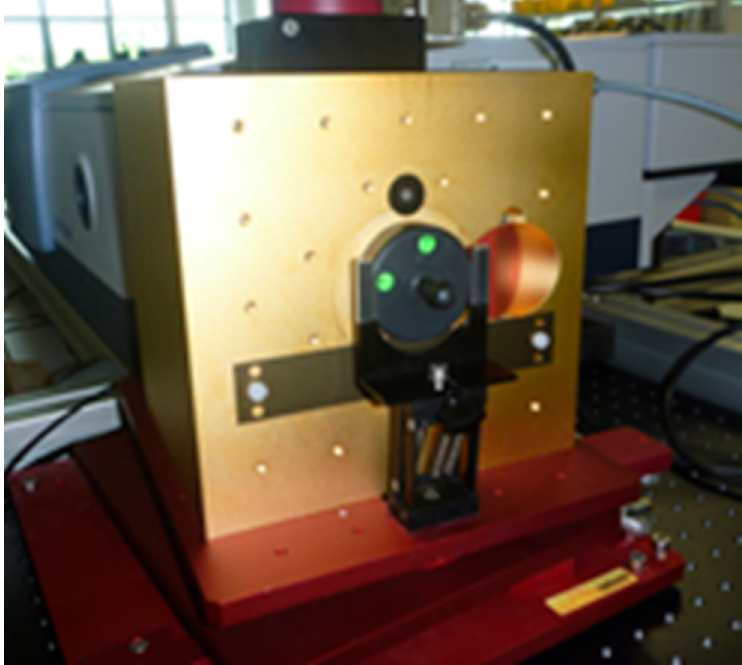
Figure A5. The integrating sphere setup at Optosol GmbH. Table A2. Standard measurement settings for the setup applied by